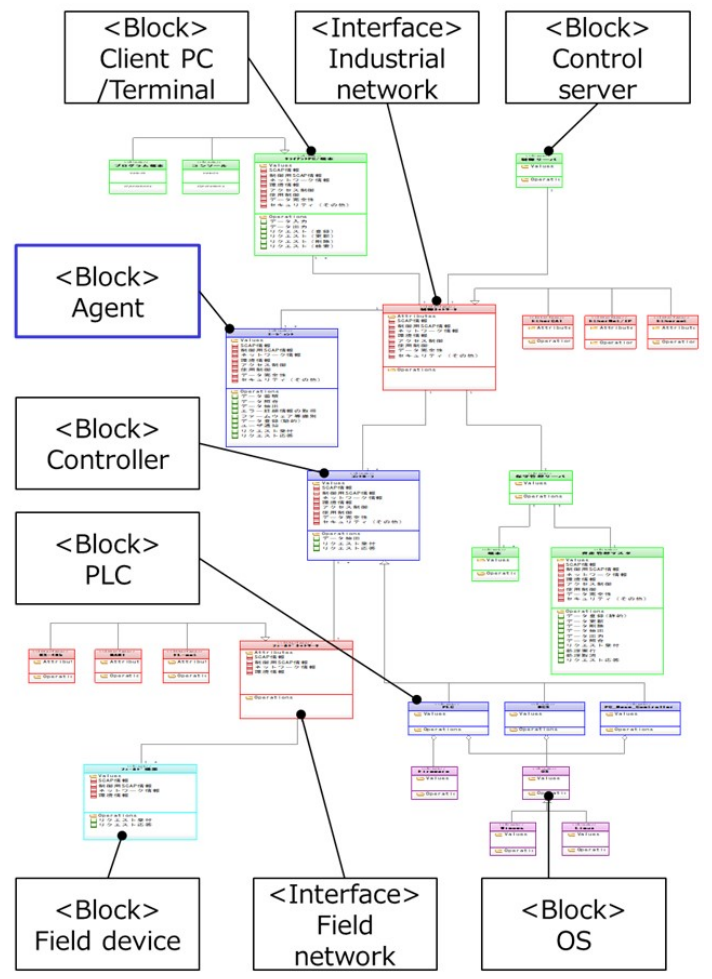
Figure 2. Reference